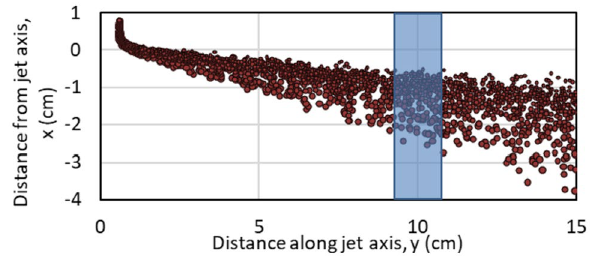
Fig. 2 The 1-cm-wide observation window located 9.5 cm from the nozzle exit is used to measure the mean particles’ axial velocity and temperature. For a powder mass flow rate of 20 g/min, at any time nearly 2,767 and 142 particles, respectively, are in the simulation region and the observation window